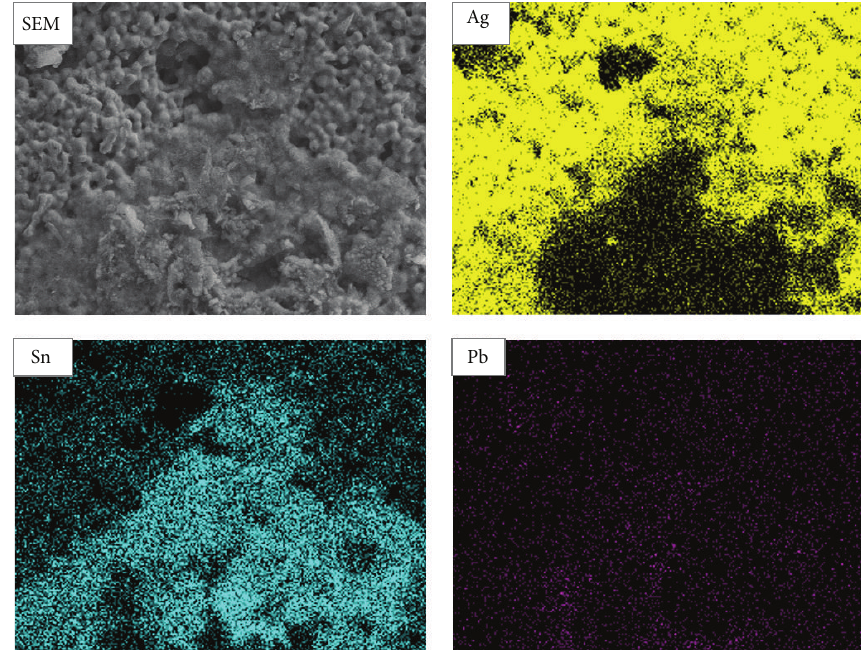
Figure 3: EDS mapping of area in Figure 2(a).